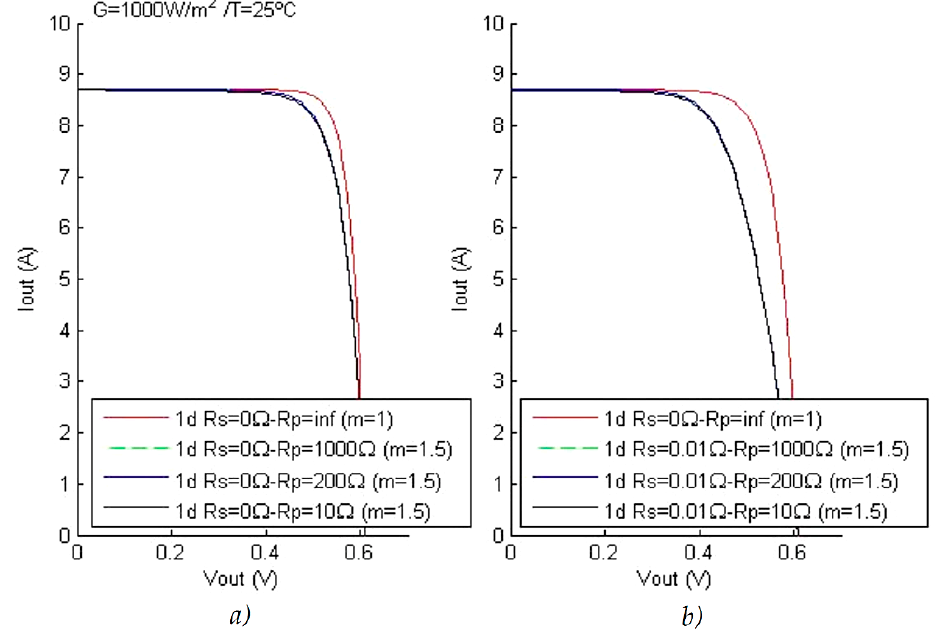
Figure 2. I - V curves as a function of the parallel resistance R p and with R s : ( a ) 0 Ω and ( b ) 10 m Ω ; (STC).